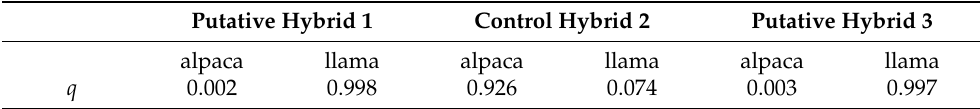
Table 2. q values of putative alpaca–llama hybrids.